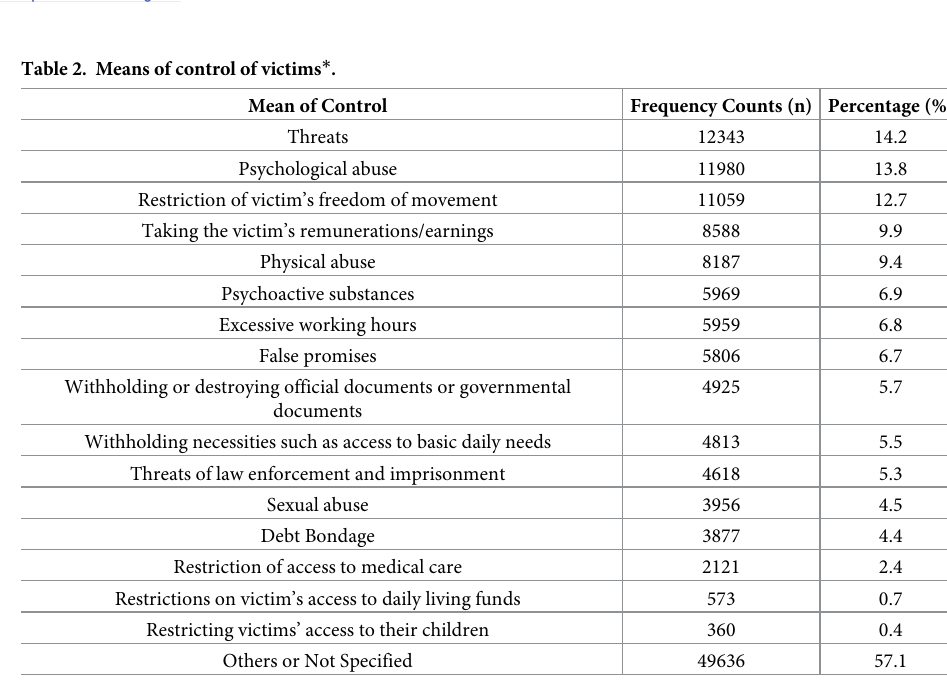
Fig 1. The number of victims per year of registration for assistance (n = 87003).